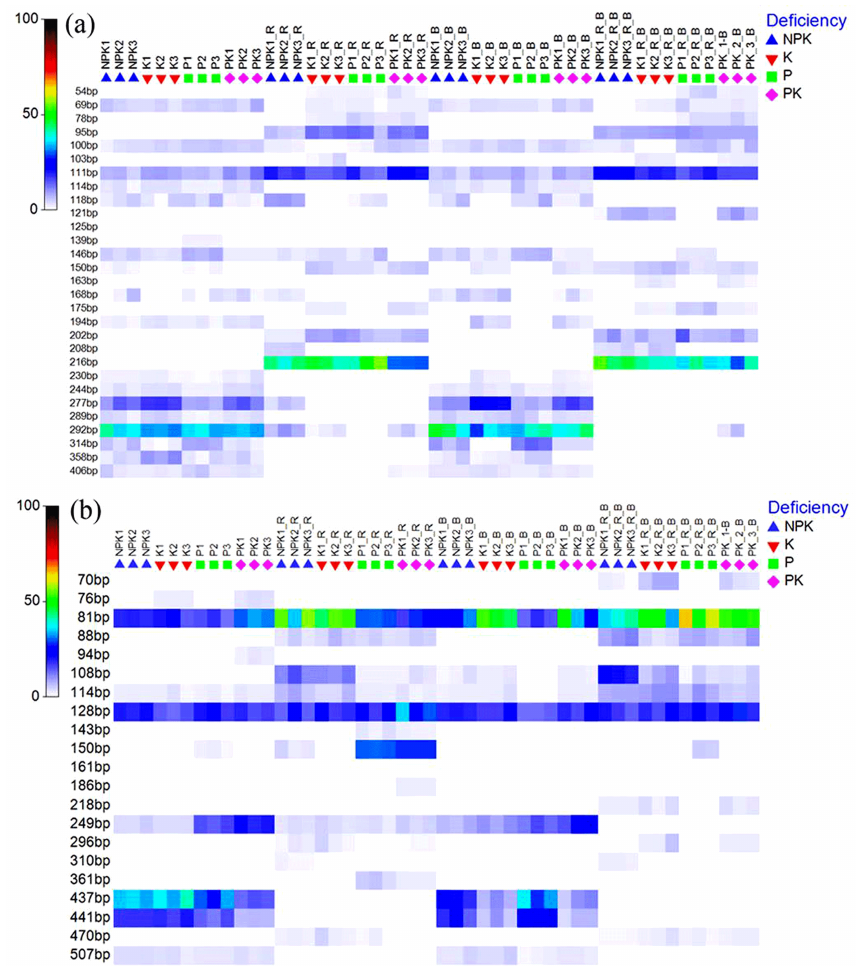
Figure 3. Heat map of mcrA - (a) and pmoA -based (b) T-RFLP profiles showing average relative abundances of mcrA T-RFs with endonuclease HaeIII and pmoA T-RFs with endonuclease HhaI in soils. The relative abundance of T-RFs is given as a percentage of the total peak height. Fragment sizes within the graph indicate the sizes (bp) of the experimental T-RFs by T-RFLP. The letter “R” after the treatments indicates samples from the mRNA-derived profile, and the letter “B” indicates the samples from ripening stage. NPK: balanced chemical fertilisation; K: potassium deficient; P: phosphorus deficient; PK: phosphorus and potassium